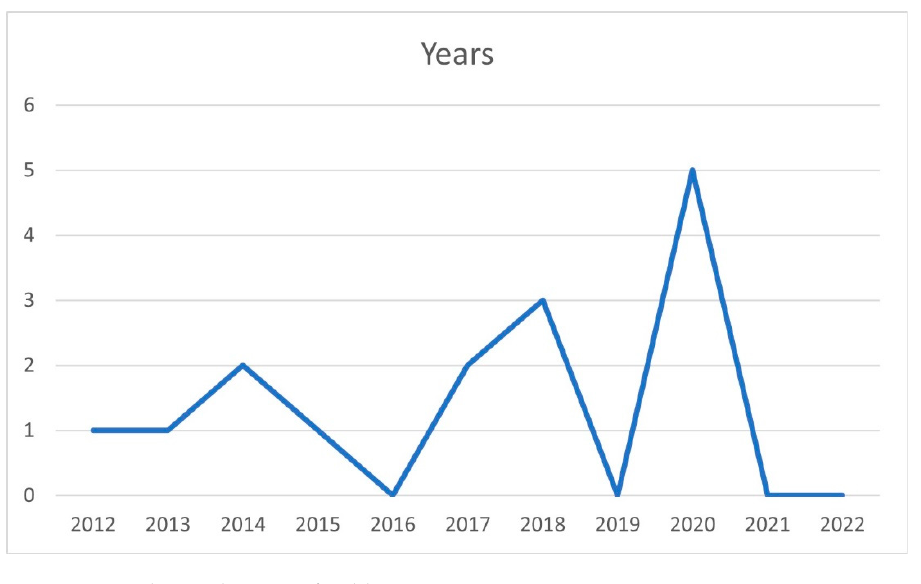
Figure 3. Distribution by year of publication.